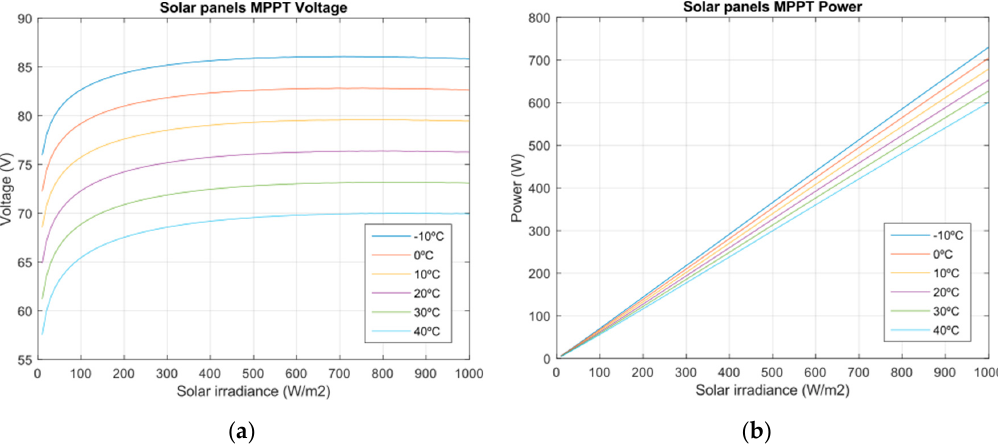
Figure 5. Solar maximum power point tracking (MPPT) outputs depending on temperature and solar irradiance. ( a ) MPPT voltage; ( b ) MPPT power generation.